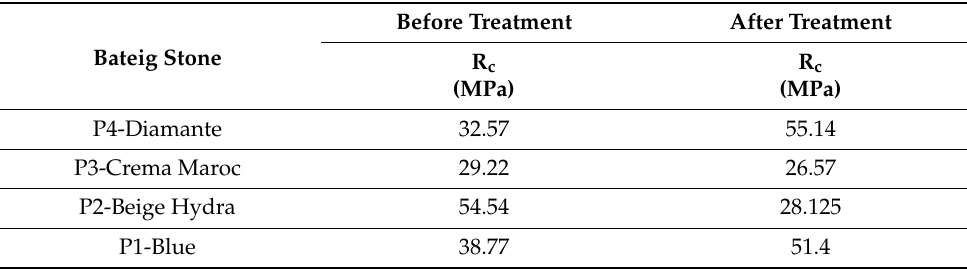
Table 16. Comparison between the values of the compressive strengths before and after the treatment of Bateig stone specimens (mean values).